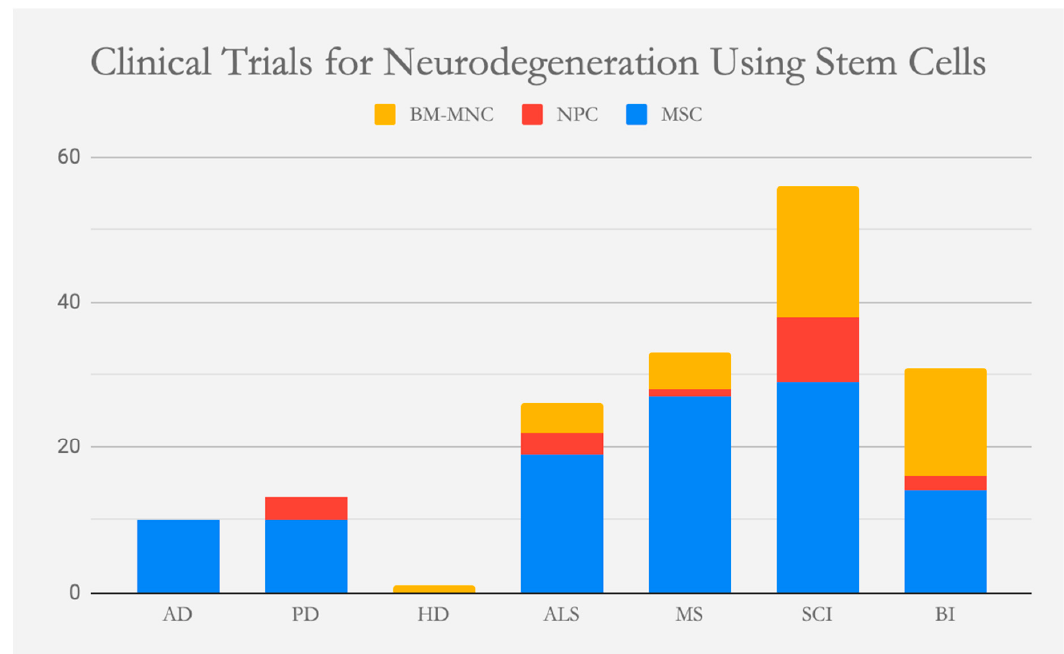
Figure 1. Clinical trials that have been or are being conducted worldwide to treat neurodegeneration using stem cells. To date, 170 clinical trials have employed mesenchymal stem cells (MSC), neural progenitor stem cells (NPC) and bone marrow-derived mononuclear cells (BM-MNC) in attempts to alleviate the neurodegeneration of Alzheimer’s disease (AD), Parkinson’s disease (PD), Huntington’s disease (HD), amyotrophic lateral sclerosis (ALS), multiple sclerosis (MS), spinal cord injury (SCI) and brain ischemia (BI). The data was collected from https://clinicaltrials.gov on 21 December 2018.